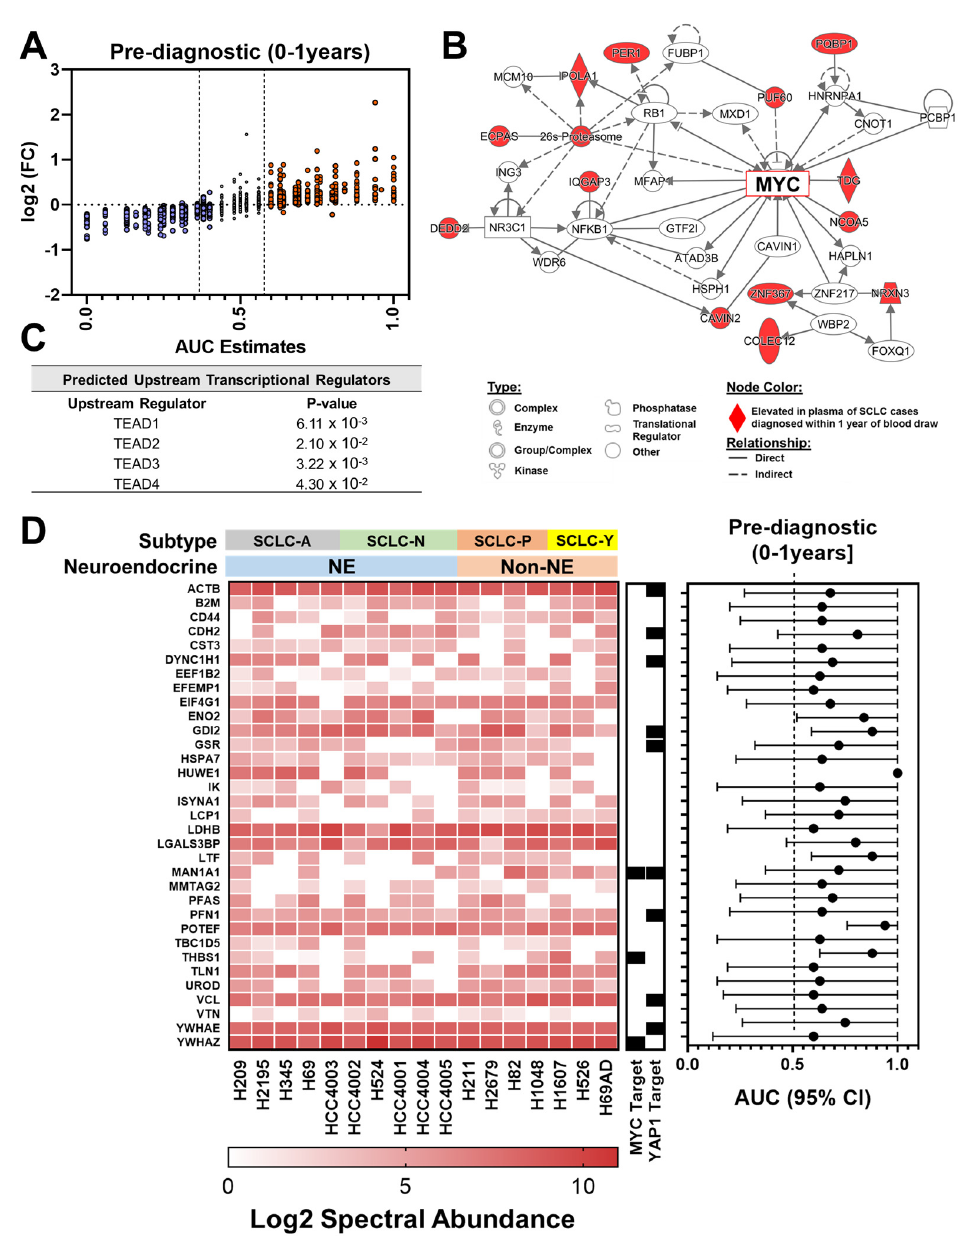
Figure 2. Proteomic signatures of MYC and YAP1 manifest in plasmas collected within one year prior to diagnosis of SCLC. ( A ) Distribution plot comparing illustrating the AUC ( x -axis) and fold-change ( y -axis) of circulating proteins for distinguishing SCLC cases diagnosed within one year of blood draw from matched controls. ( B , C ) Ingenuity Pathway Analyses (IPA) on circulating proteins that exhibited an AUC ≥ 0.60 for distinguishing SCLC cases diagnosed within one year of blood draw from matched controls reveals MYC ( B ) and YAP1-centric signatures ( C ). ( D ) Heatmap illustrating the 33 proteins that were quantified in conditioned medium of SCLC cell lines ( n = 17) and that were elevated in plasmas of SCLC cases diagnosed within one year of blood draw. The center plot annotates whether the respective protein is a reported downstream transcriptional target (black square) of MYC or YAP1. ChIP Enrichment Analysis (ChEA) transcriptional targets of c-MYC and YAP1 were downloaded from Harmonizome database [29,30]. The scatter plot on the right depicts the AUC (95% CI) of respective proteins for distinguishing SCLC cases from matched controls in the pre-diagnostic (0–1 year] dataset.